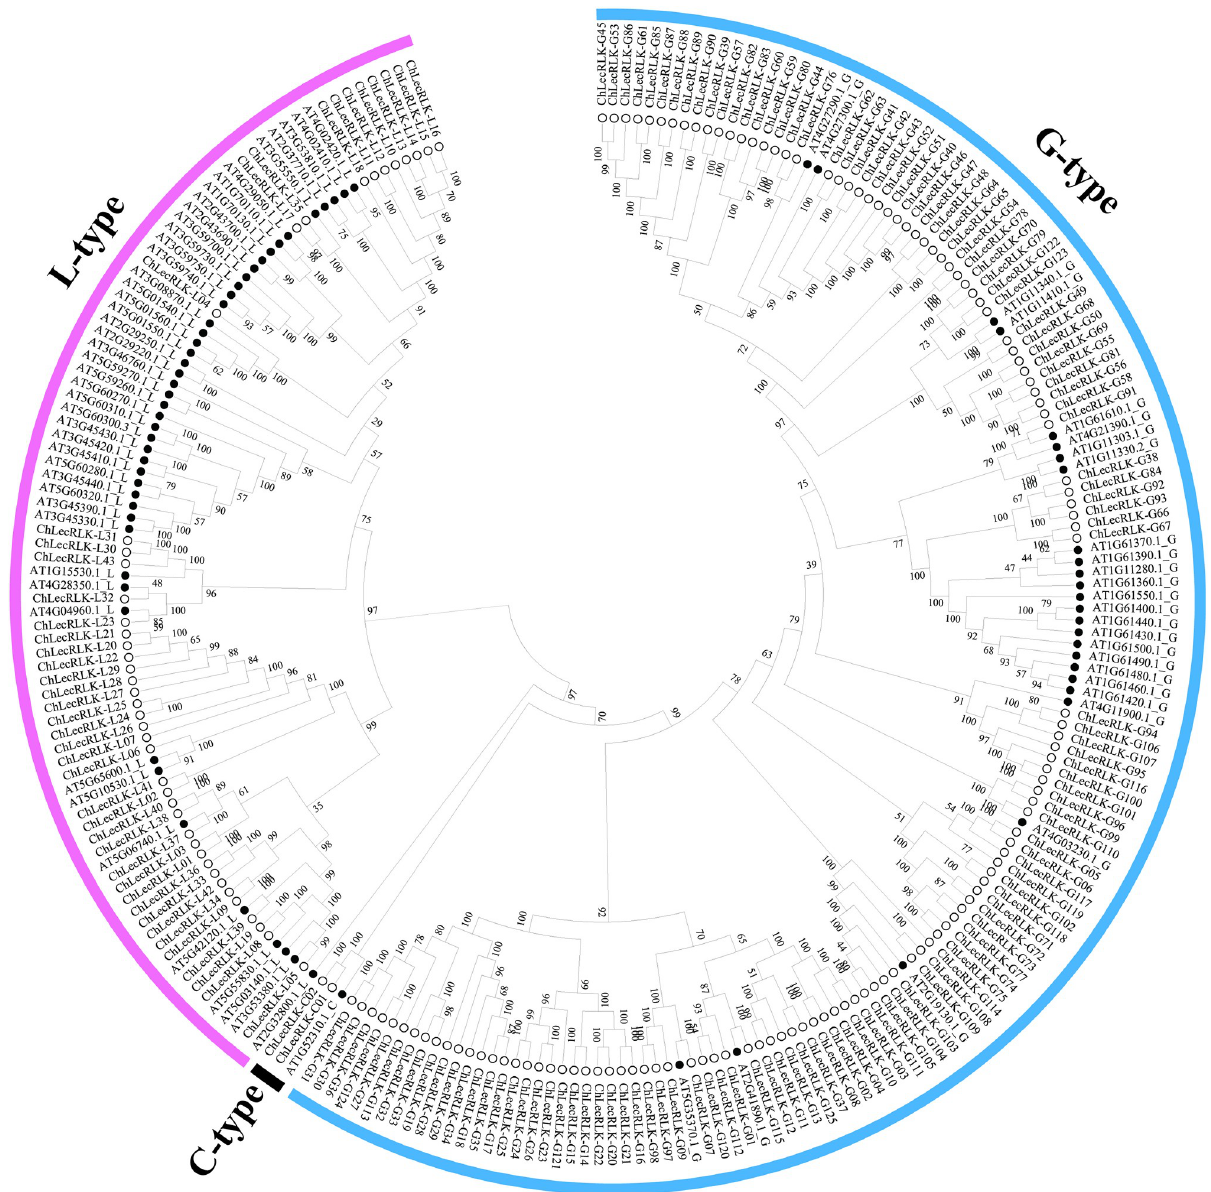
Fig 1. Classification of 170 LecRLKs genes discovered from the whole genome of C . humilis . The phylogenetic tree was constructed by the neighbor- joining (NJ) method. Solid black dots represent LecRLKs genes of Arabidopsis thaliana , hollow circles represent LecRLKs genes of C . humilis